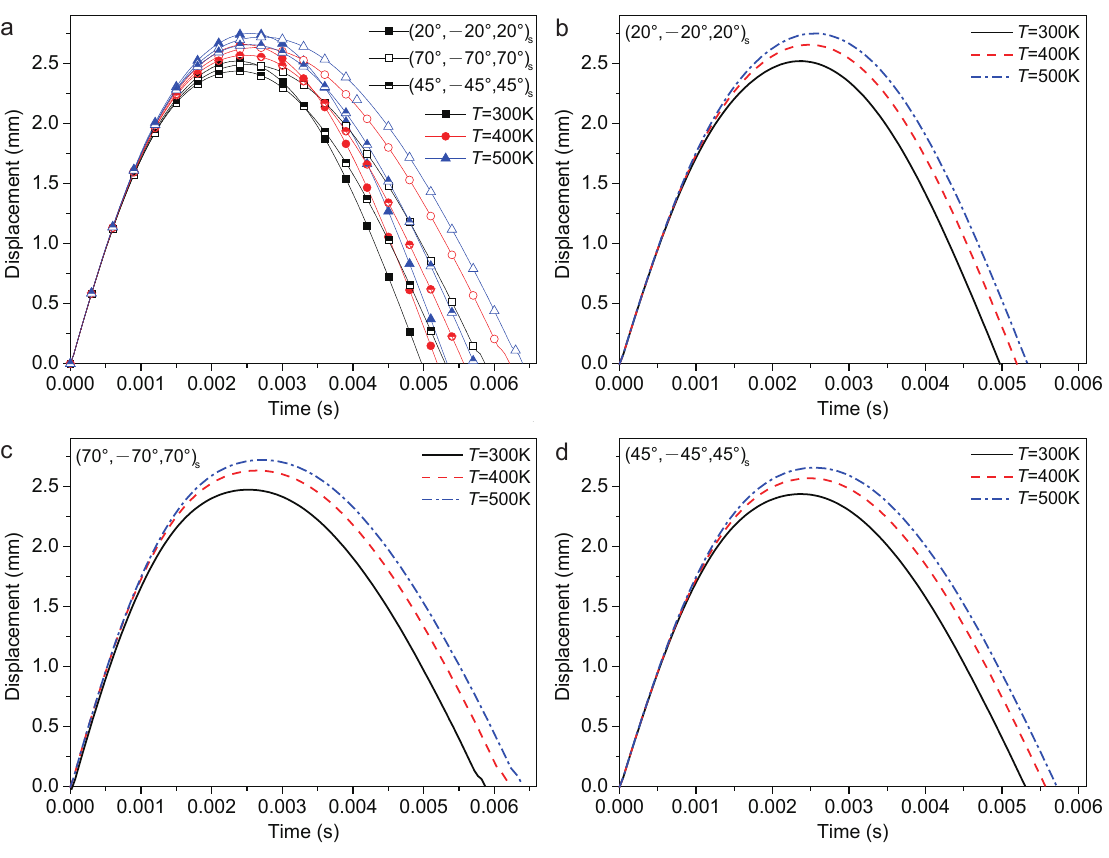
Figure 11. Plate center displacement response of the sandwich structure with various temperatures: ( a ) FG-O, UD and FG-V face sheets plate; ( b ) (20/ − 20/20)s plate; ( c ) (70/ − 70/70)s plate; and ( d ) (45/ − 45/45)s